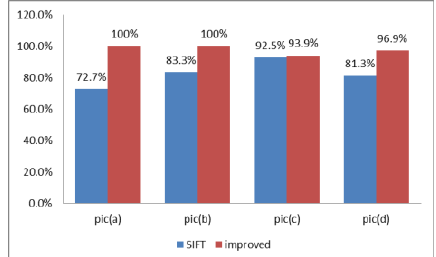
Figure 4(b) matching correct rate by SIFT algorithm and improved algorithm. Blue bar for SIFT algorithm and red bar for zero-crossing algorithm. The x-axis showed different group of test images and the y-axis stands for the matching correct rate.